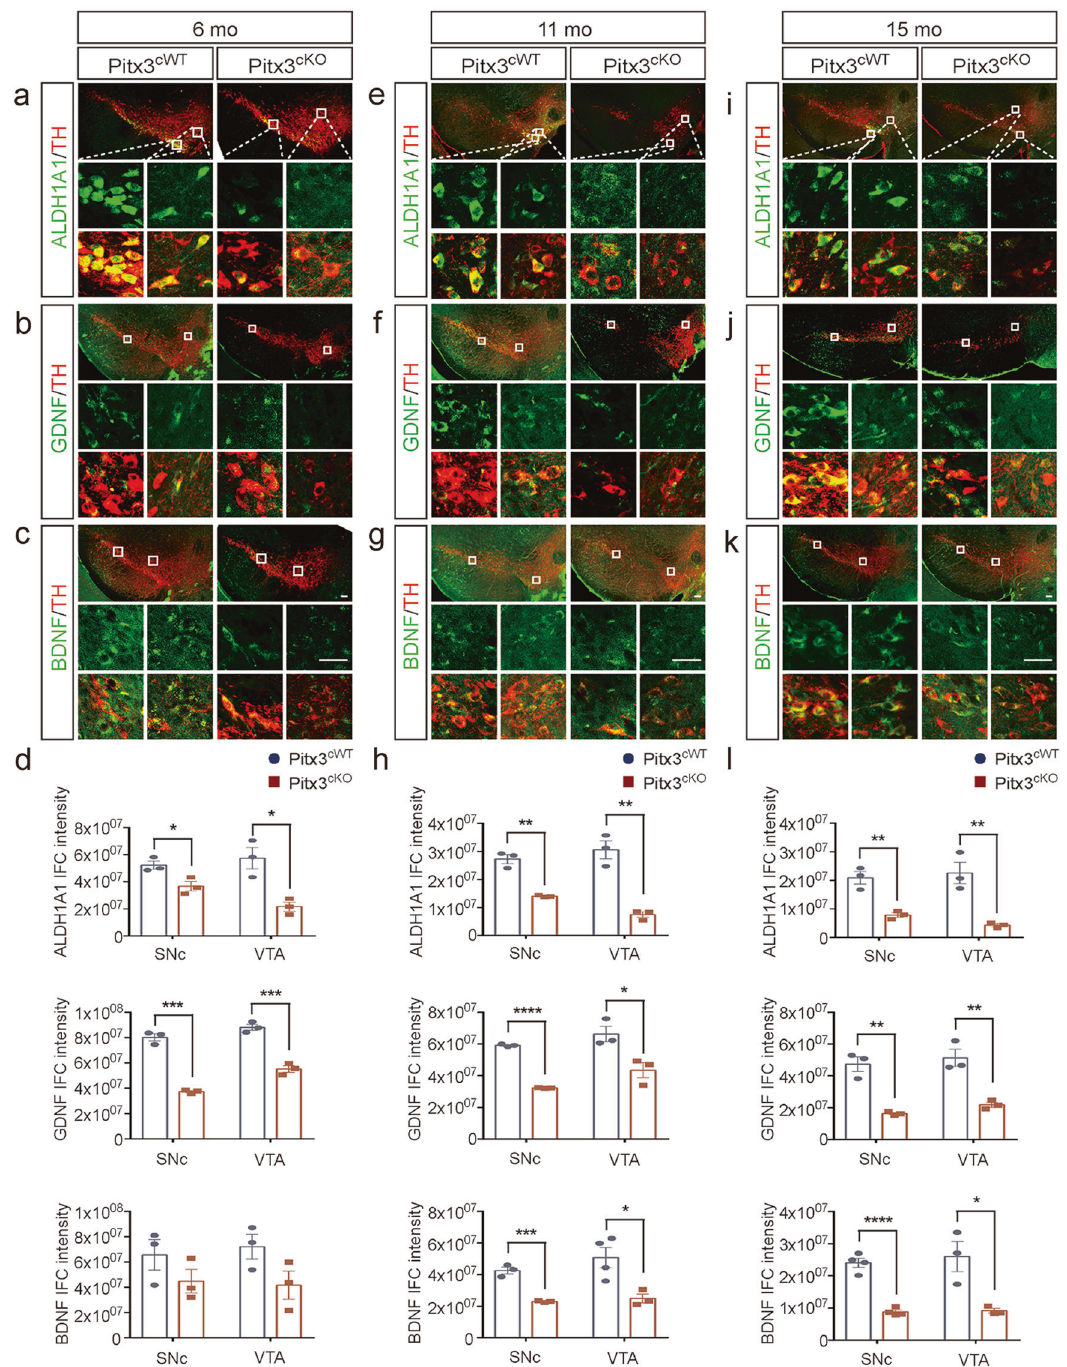
Fig. 5 Expression analysis of Pitx3 -related genes in Pitx3 cKO mice. Co-staining of Aldh1a1 and TH ( a , e , i ), GDNF and TH ( b , f , j ), and BDNF and TH ( c , g , k ) in the SNc and VTA from 6-, 11-, and 15-month-old Pitx3 cWT and Pitx3 cKO mice (scale bar: 100 μ m; high-magni fi cation, 25 μ m). d , h , l Quanti fi cation of IFC intensity of Aldh1a1, GDNF, and BDNF in the SNc and VTA from 6-, 11-, and 15-month-old Pitx3 cWT and Pitx3 cKO mice ( N = 3 – 4 mice per genotype). Unpaired t -test, * p = 0.0288 (Aldh1a1, 6 months old for SNc); *** p = 0.0001 (GDNF, 6 months old for SNc); * p = 0.0138 (Aldh1a1, 6 months old for VTA); *** p = 0.0007 (GDNF, 6 months old for VTA); ** p = 0.0012 (Aldh1a1, 11 months old for SNc); **** p < 0.0001 (GDNF, 11 months old for SNc); *** p = 0.0002 (BDNF, 11 months old for SNc); ** p = 0.0023 (Aldh1a1, 11 months old for VTA); * p = 0.0285 (GDNF, 11 months old for VTA); * p = 0.0225 (BDNF, 11 months old VTA); ** p = 0.0052 (Aldh1a1, 15 months old for SNc); ** p = 0.0026 (GDNF, 15 months old for SNc); **** p < 0.0001 (BDNF, 15 months old for SNc); ** p = 0.0086 (Aldh1a1, 15 months old for VTA); ** p = 0.0062 (GDNF, 15 months old for VTA); and * p = 0.0237 (BDNF, 15 months old for